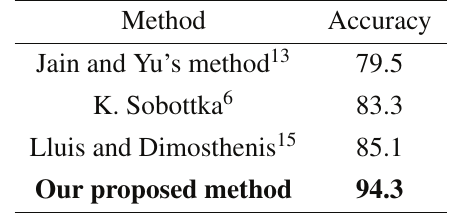
Table 1: Accuracy comparison on our test dataset